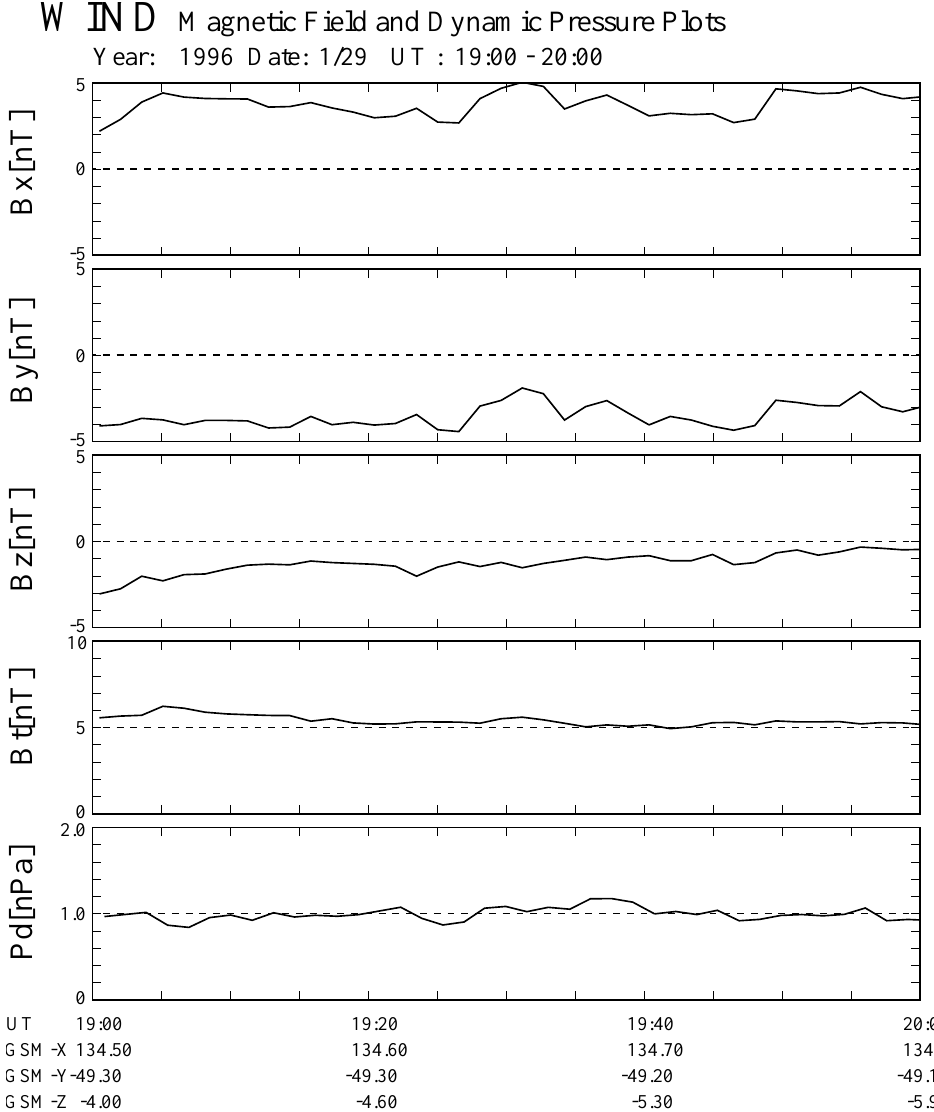
Figure 4 Fig. 4. Plots of the solar wind condition observed by the WIND spacecraft during a one-hour interval from 19:00:00 UT to 20:00:00 UT on